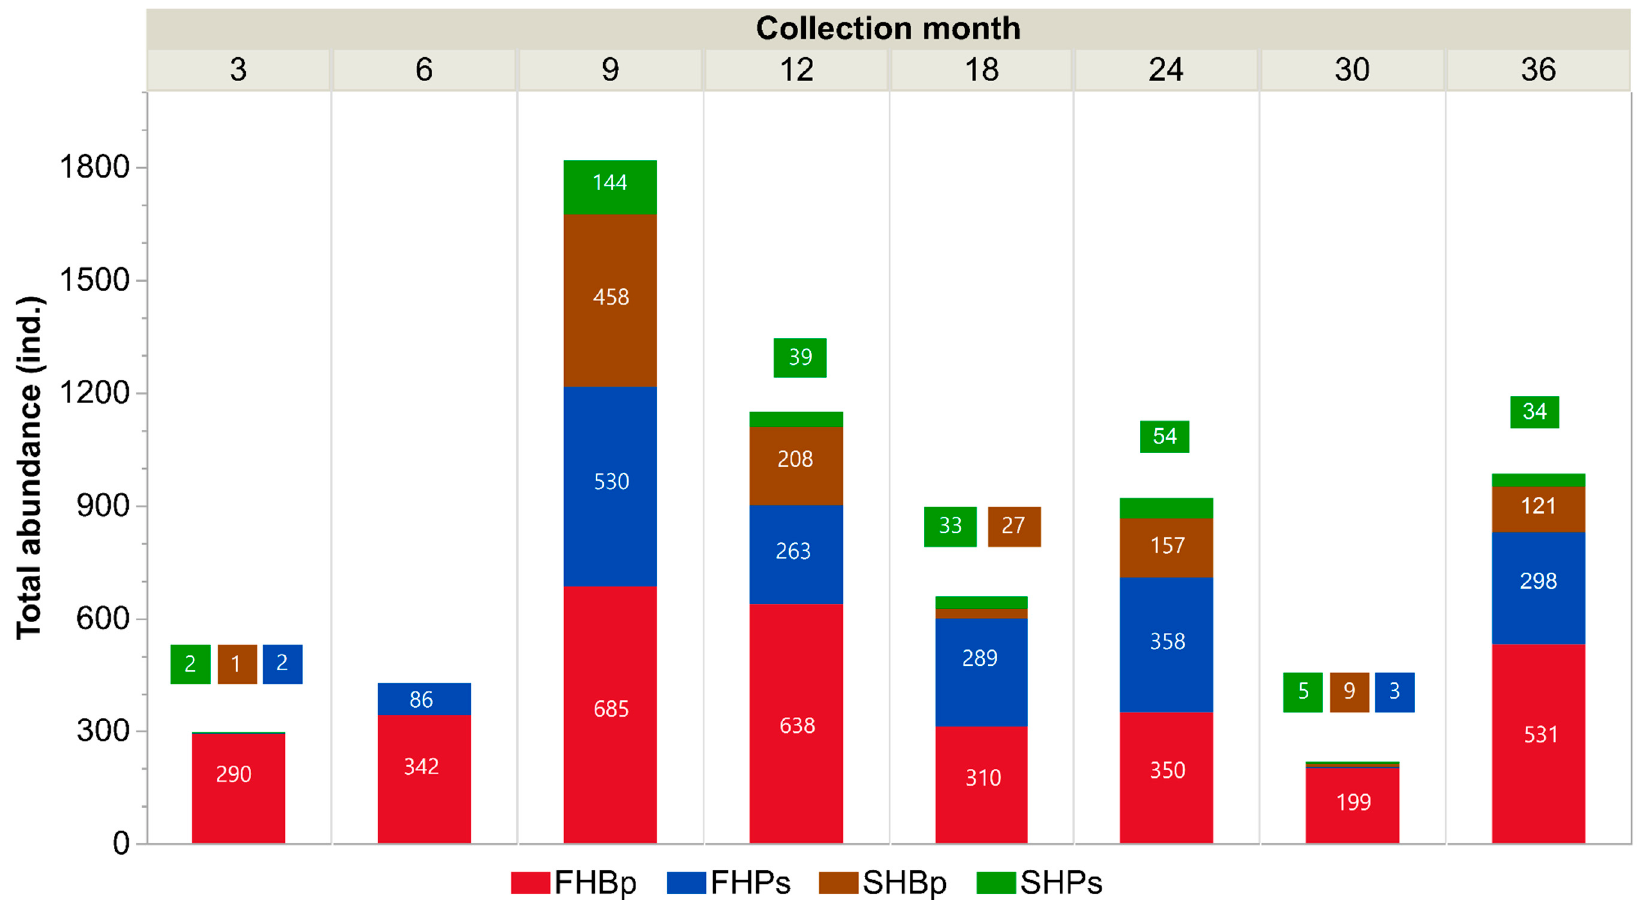
Figure 1. Number of gamasid mite individuals collected in Betula pendula Roth (Bp) and Pinus sylvestris L. (Ps) stands growing in forest habitat (FH) and spoil heap (SH) by collection month during the experiment. When total abundance was very low, we have added numbers and respective colors above the bars.